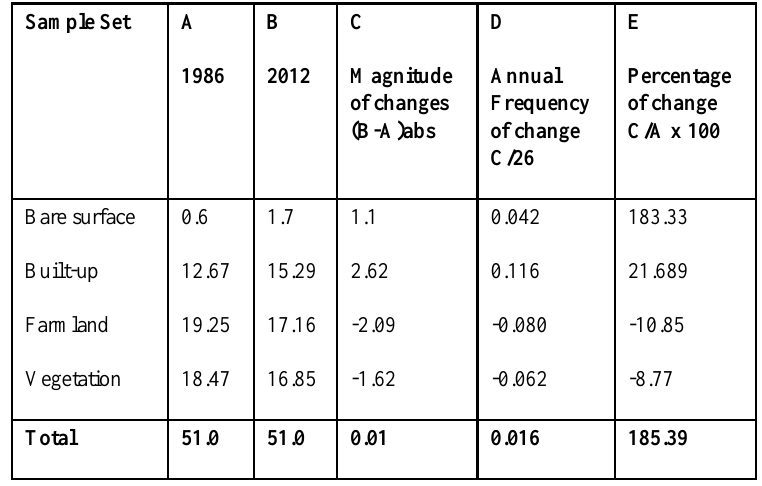
Table 5-Magnitude and percentage of change in Landcover between 1975 and 1986.